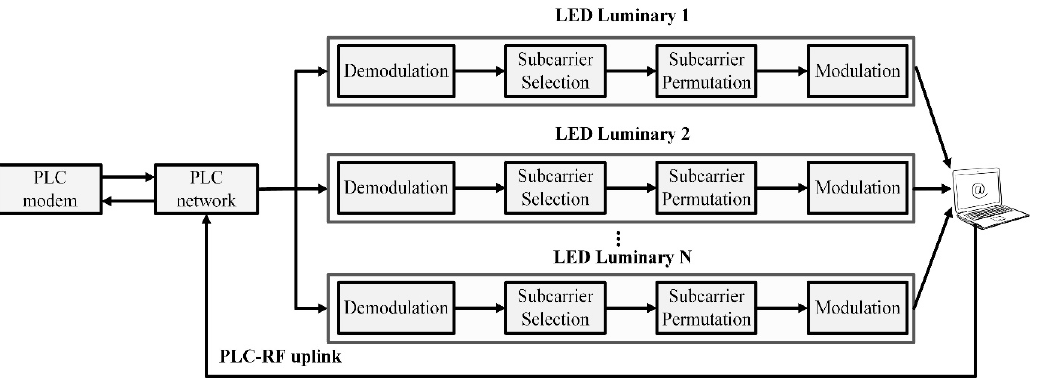
Figure 8. Block diagram of the hybrid IWOC and PLC for indoor multiuser downlink [14,23].